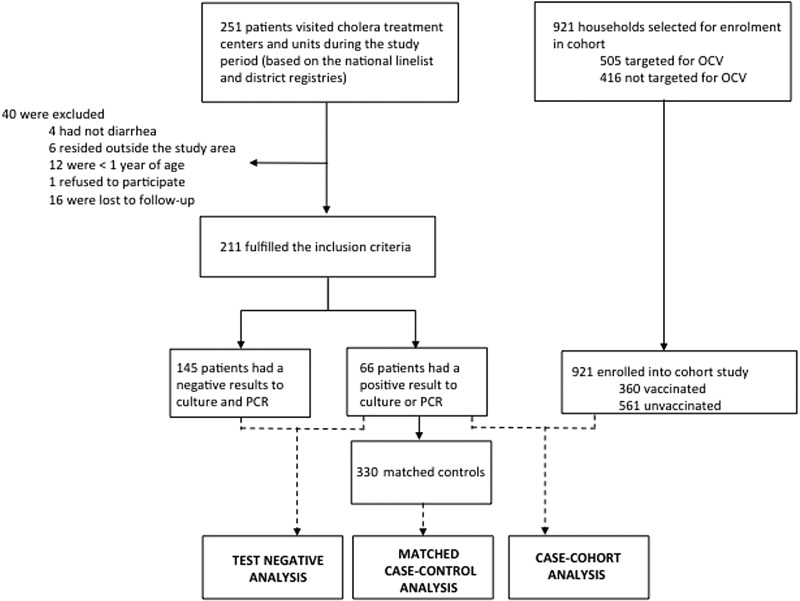
Study flowchart.